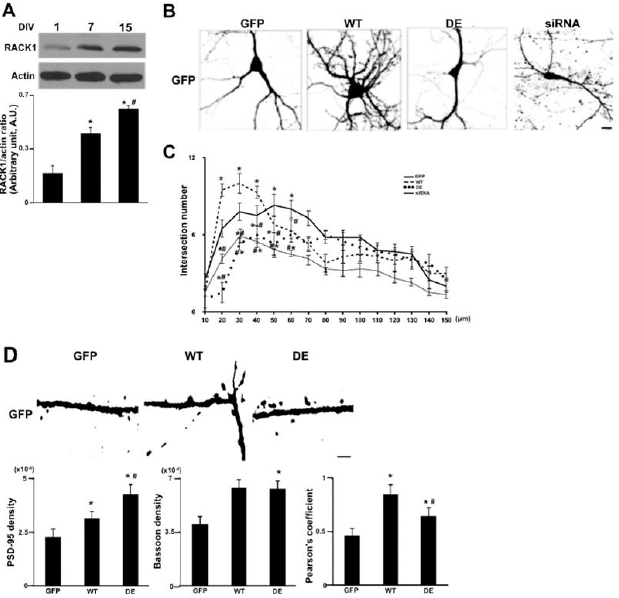
Figure 1. The ribosomal RACK1 regulates dendritic arborization. ( A ) Immunoblotting for RACK1 and actin on total protein lysate from embryonic mouse hippocampal neurons cultured from 1 DIV to 17 DIV. ( Lower ) The graph reports the means of three independent experiments of density ratio between RACK1 and actin bands (mean ± S.D.). Student’s T-test was used to calculate p values: * p ≤ 0.05 vs. 1 DIV; # p ≤ 0.01 vs. 7 DIV. B) Immunofluorescence for GFP on hippocampal neurons transfected at 15 DIV with GFP, GFP/RACK1 WT-his-myc (WT in the figure), GFP/RACK1 DE-his-myc (DE) or RACK1 siRNA (siRNA). Scale 10 µ m. ( C ) The graph of Scholl analysis performed on cells in ( B ). The values were measured as means of the number of neurite intersections measured by Sholl analysis. Data are graphed as mean ± S.D. Student’s T-test was used to calculate p values: * p ≤ 0.01, vs. GFP; # p ≤ 0.05 vs. RWT -his-myc; ( D ) Graphic of PSD-95, Bassoon density and Pearson’s coefficient of puncta between PSD-95 and Bassoon measured by immunofluorescence experiments. Graph reporting the correlation measured by Pearson coefficient of the puncta signal between PSD-95 and Bassoon in Supplemental Figure S2. All bars represent mean ± SD; n.70 puncta from three independent experiments. One-way ANOVA with Tukey’s Post Hoc test. Data are graphed as mean ± S.E.* p ≤ 0.005, vs. GFP; # p ≤ 0.05, vs. WT.